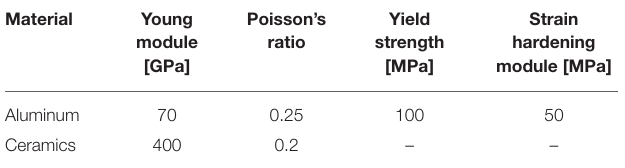
TABLE 1 | Material constants used in the